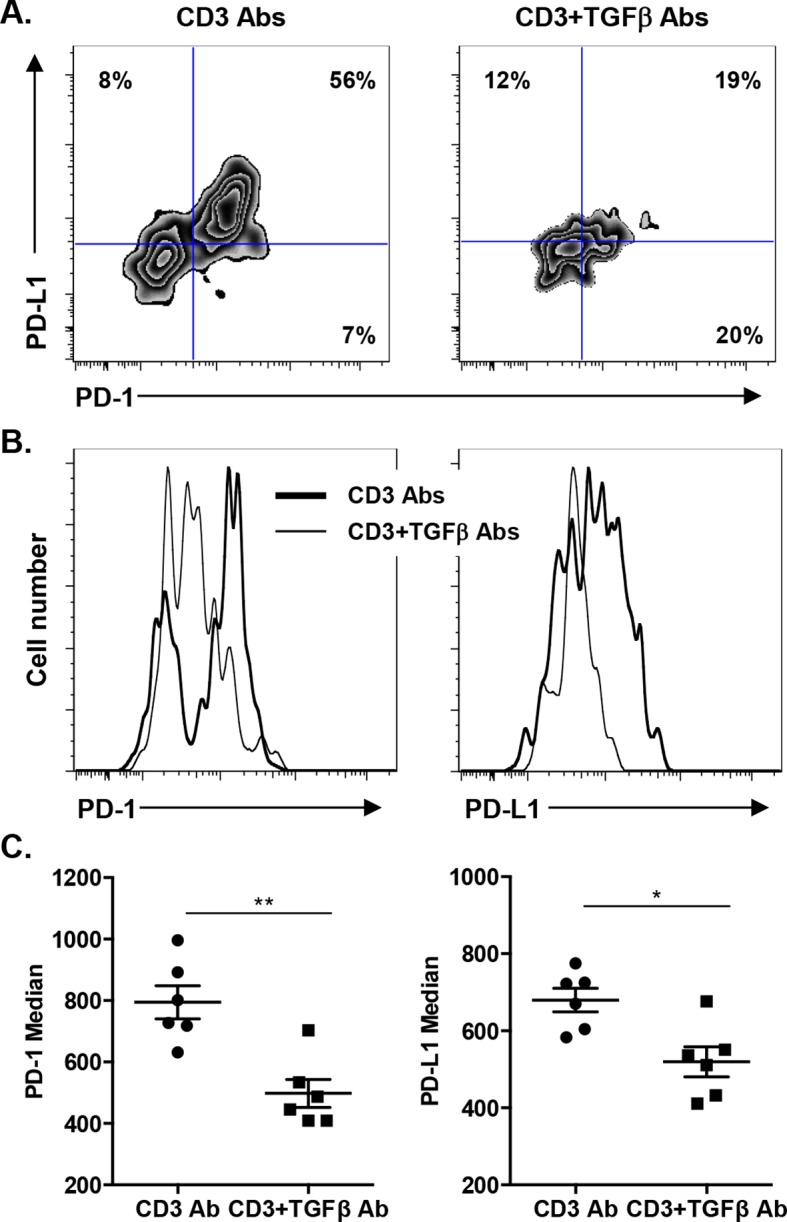
Induction of PD-1 and PD-L1 expression on intragraft CD8+ T cells is regulated by TGFβ.C57BL/6 mice were transplanted with BALB/c pancreatic islets and treated at day 7 with anti-CD3 F(ab’)2 with or without neutralizing TGFβ antibodies. Mice were sacrificed on day 14 post-transplant and PD-1 and PD-L1 expressions were analyzed on graft-infiltrating CD8+ T cells. (A) Co-expression of PD-1 and PD-L1 on CD8+ T cells. (B) Histograms representing PD-1 and PD-L1 expression. (C) Median fluorescence intensity of PD-1 and PD-L1 (*p<0.02, **p<0.005).